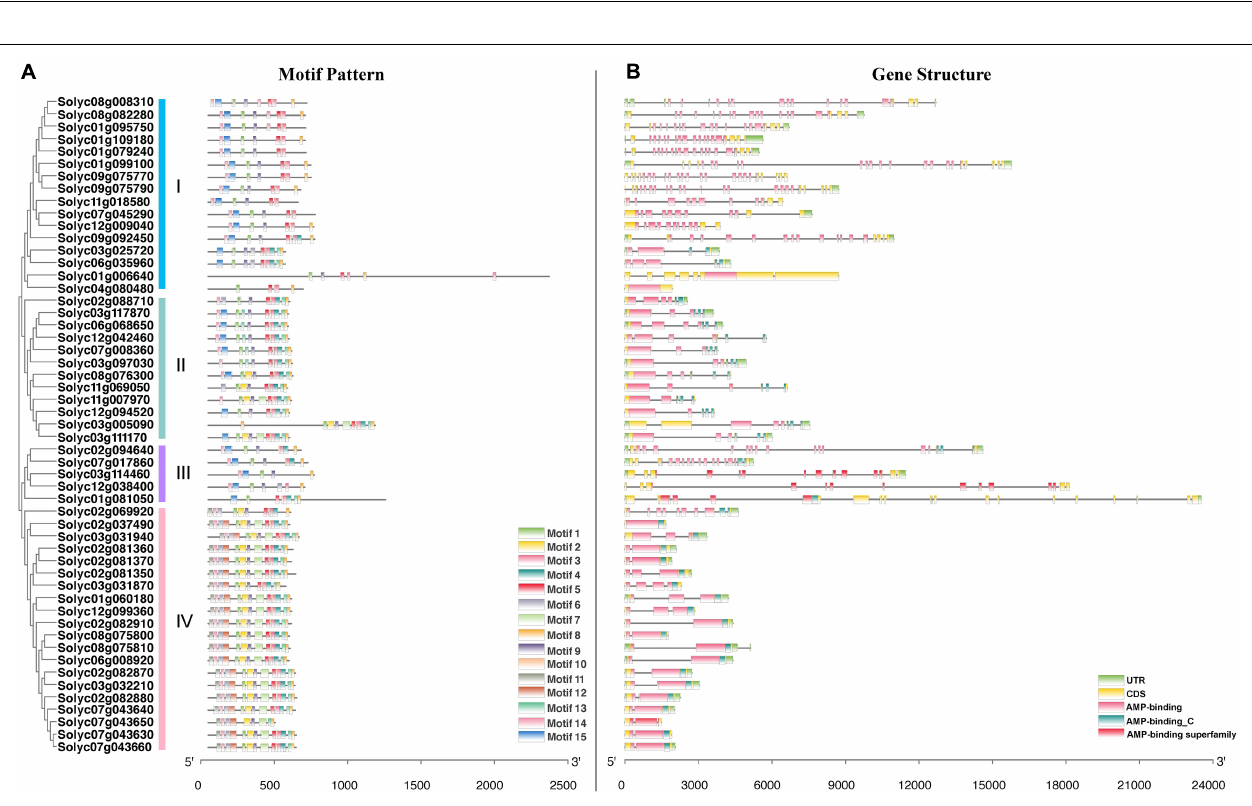
FIGURE 3 | Phylogenetic relationships, gene structure, and architecture of conserved protein motifs in AAE genes from tomato. (A) The motif composition of tomato acyl-activating enzyme (AAE) proteins in accordance to the phylogenetic relationship. Fifteen motifs are shown in different colored boxes. The length of motifs in each AAE protein was displayed proportionally. (B) The exon-intron structure of SlAAE genes. Each exon-intron structure analysis of tomato AAE genes was completed using the online tool GSDS. The length of gene can be estimated using the scale at the bottom.